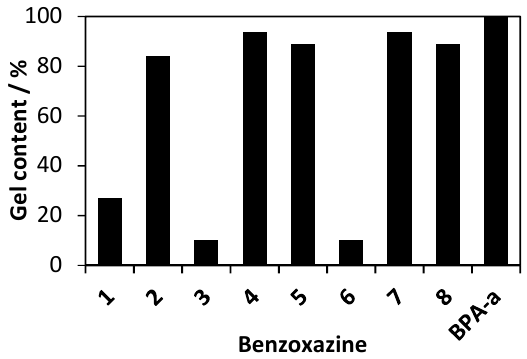
Figure 2. Gel content of polybenzoxazines derived from monobenzoxazines determined by acetone extraction. BPA-a corresponds to the polybenzoxazine prepared from the bisbenzoxazine, previously synthesized by us, derived from bisphenol A and aniline under our conditions.